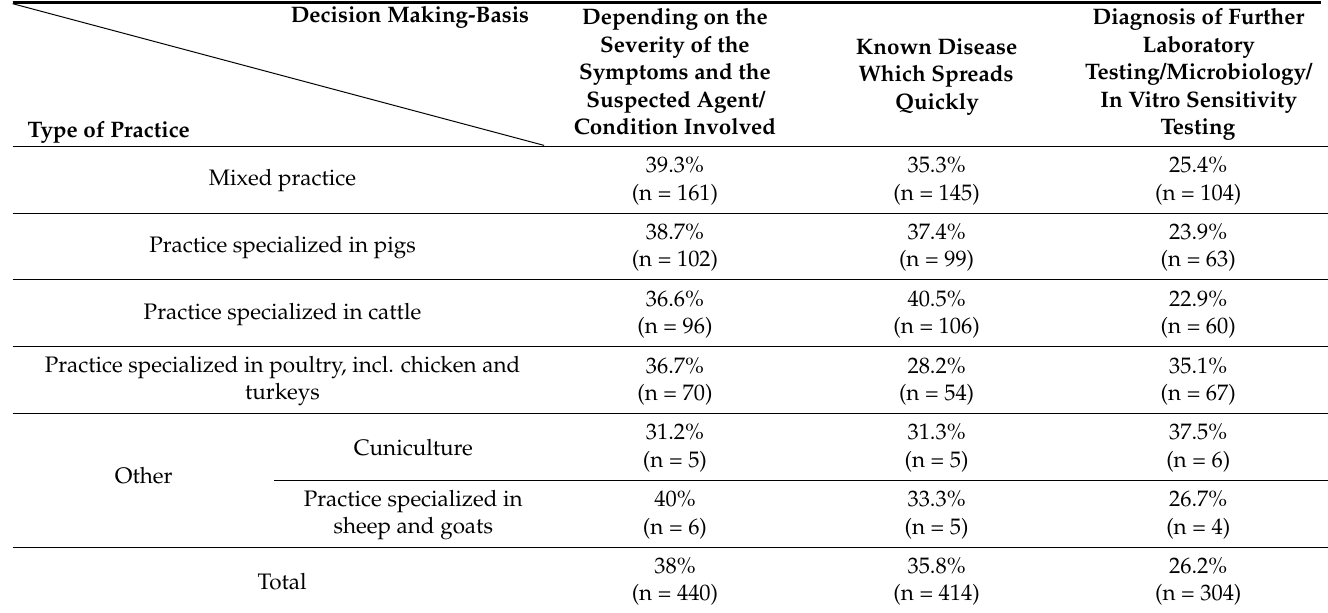
Table 1. Basis of decision making in absolute numbers (Q7 with n = 1158 survey responses, multiple an- swers possible) and percent for each decision option per practice type to initiate metaphylactic